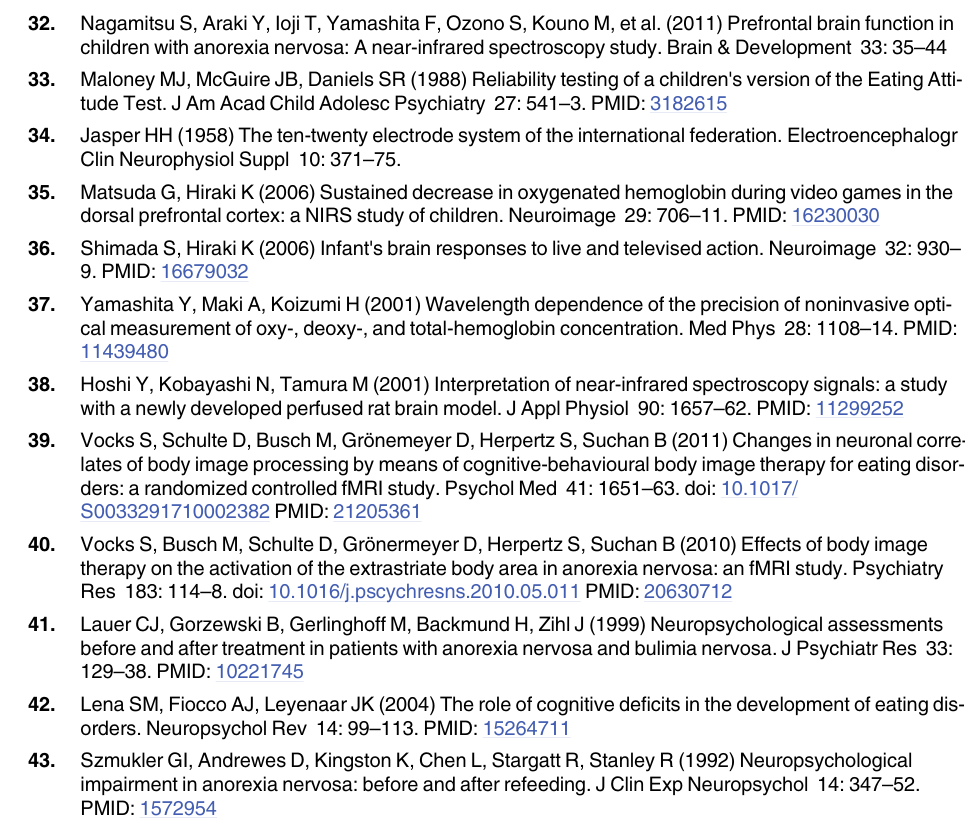
PLOS ONE | DOI:10.1371/journal.pone.0132050 July 7, 2015 12 /